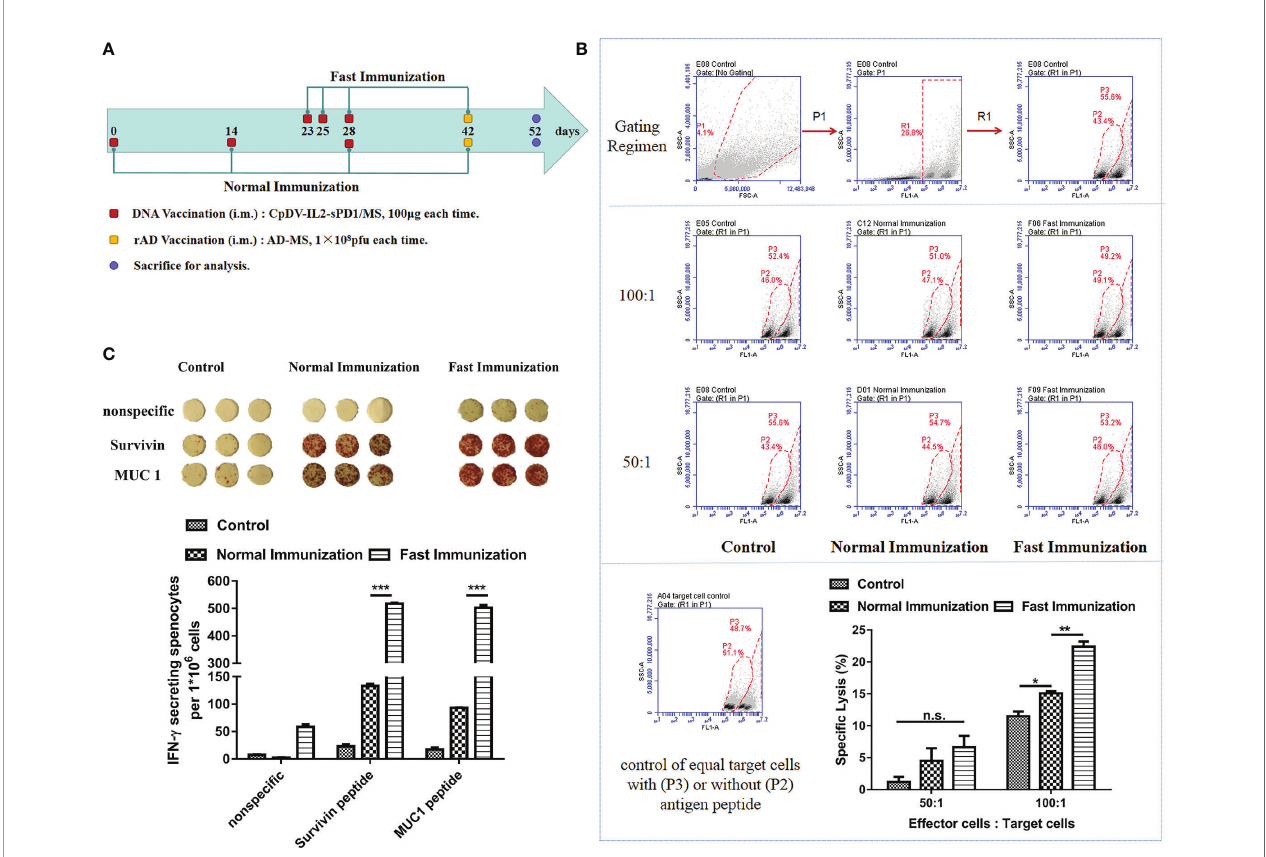
FIGURE 3 | The fast immunization strategy elicited stronger antigen-speci fi c immune responses than did the normal immunization strategy. (A) Immunization regimen in BALB/c mice. Three groups of BALB/c mice ( fi ve mice per group) were vaccinated intramuscularly with CpDV-IL2-sPD1/MS (100 µg in 100 µl) or PBS (negative control) three times. DNA vaccines were administered at 2-week intervals in the normal immunization group or on days 23, 25, and 28 in the fast immunization group. Recombinant adenovirus (rAd) (1 × 10 8 pfu in 100 µl per mouse) was administered 2 weeks after the last vaccination (day 42) in both groups. PBS was administered under the fast immunization regimen as a negative control. Ten days after rAd vaccination (day 52), all mice were sacri fi ced to evaluate the immune response. (B) CTL assay. CT26 and CT26-GFP-MS were labeled with carboxy fl uorescein diacetate succinimidyl ester (CFSE) of different concentrations (0.5 m M and 5 m M). Splenocytes and a mixture of target cells were incubated at ratios of 50:1 and 100:1, respectively, for 8 h at 37°C, 5% CO 2 . The percentage of cell death was determined via fl ow cytometry. Gating for CT26 and CT26-GFP-MS target cells treated with different CFSE concentrations was performed (upper panel). The percentage of CT26-GFP-MS (P3 Gate) and CT26 (P2 Gate) are shown (middle panel). The percentage of speci fi c cytolysis was calculated (lower panel) (C) ELISpot assay. Splenocytes were incubated with hSurvivin peptide (H2-K d sequence: AFLSVKKQF, fi nal concentration: 10 µg/ml) and hMUC1 peptide (H2-K d sequence: APDTRPAPG, fi nal concentration: 10 µg/ml), and the secretion of IFN- g per million splenocytes (ELISpot assay) was detected. (n.s., p > 0.05, *p < 0.05, **p < 0.01, ***p <